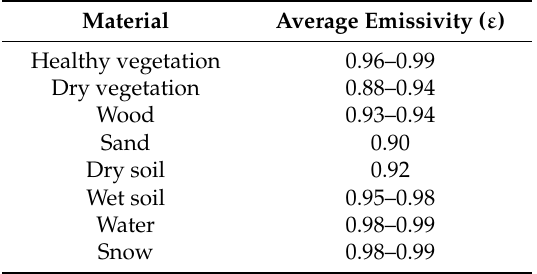
Table 1. The emissivity of di ff erent surfaces over the range of 8–14 µ m